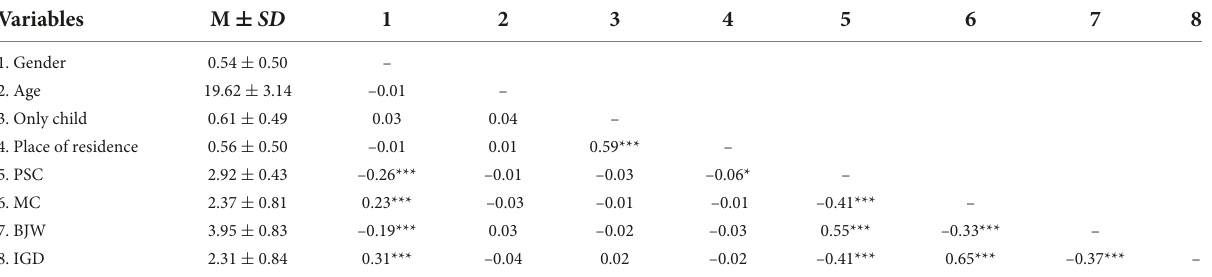
TABLE 3 Descriptive statistics and intercorrelations between